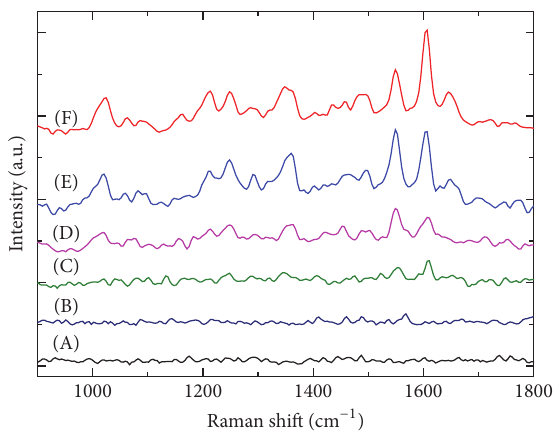
Figure 2: Raman spectra of (A) Z-CPPs and (B) Au-Z-CPPs in the aqueous solution.